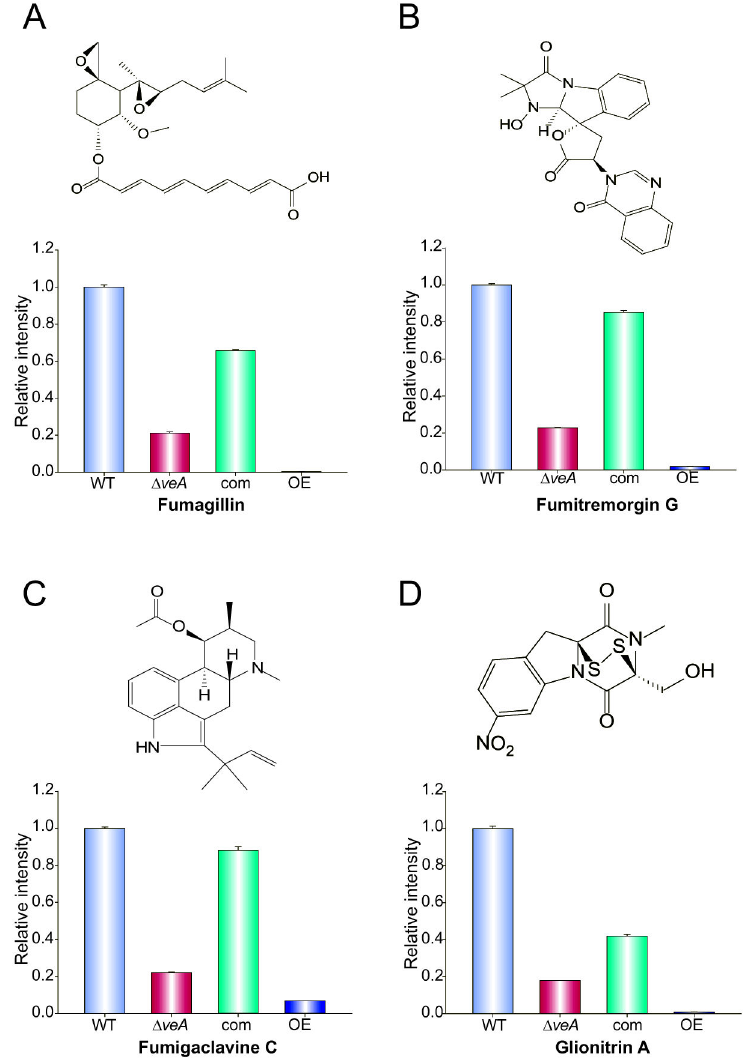
Figure 4. veA regulates the production of fumagillin, fumitremorgin G, fumigaclavine C and Glionitrin A. Secondary metabolites were extracted from 120 h old Czapek-dox stationary liquid cultures of wild type (WT), Δ veA , complementation and OE veA strains. Extracts were analyzed with Shimadzu 2010 EV LC-MS as described in the materials and methods section. The predicted m/z [M+H] + ratio was (A) fumagillin (m/z=459), (B) fumitremorgin G (m/z = 433) (C) fumigaclavine C (m/z = 299) and (D) Glionitrin-A (m/z = 354). The bars represent the mean of three samples and error bars represent standard error.